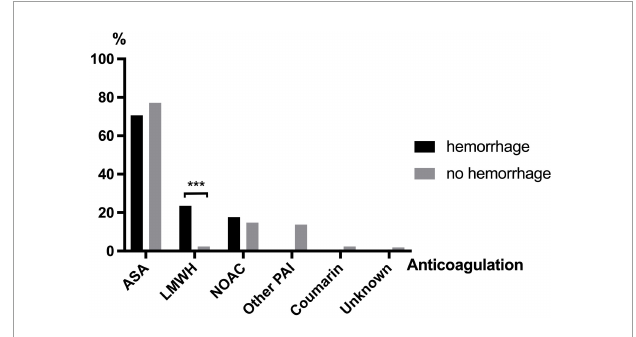
FIGURE1 Anticoagulants taken in patients with and without cerebral hemorrhage after TBI (ASA, acetylsalicylic acid; LMWH, low-molecular-weight heparin; NOAC, novel oral anticoagulants; PAI, platelet aggregation inhibitor). * p ≤ 0.05, ** p ≤ 0.01, and *** p < 0.001.